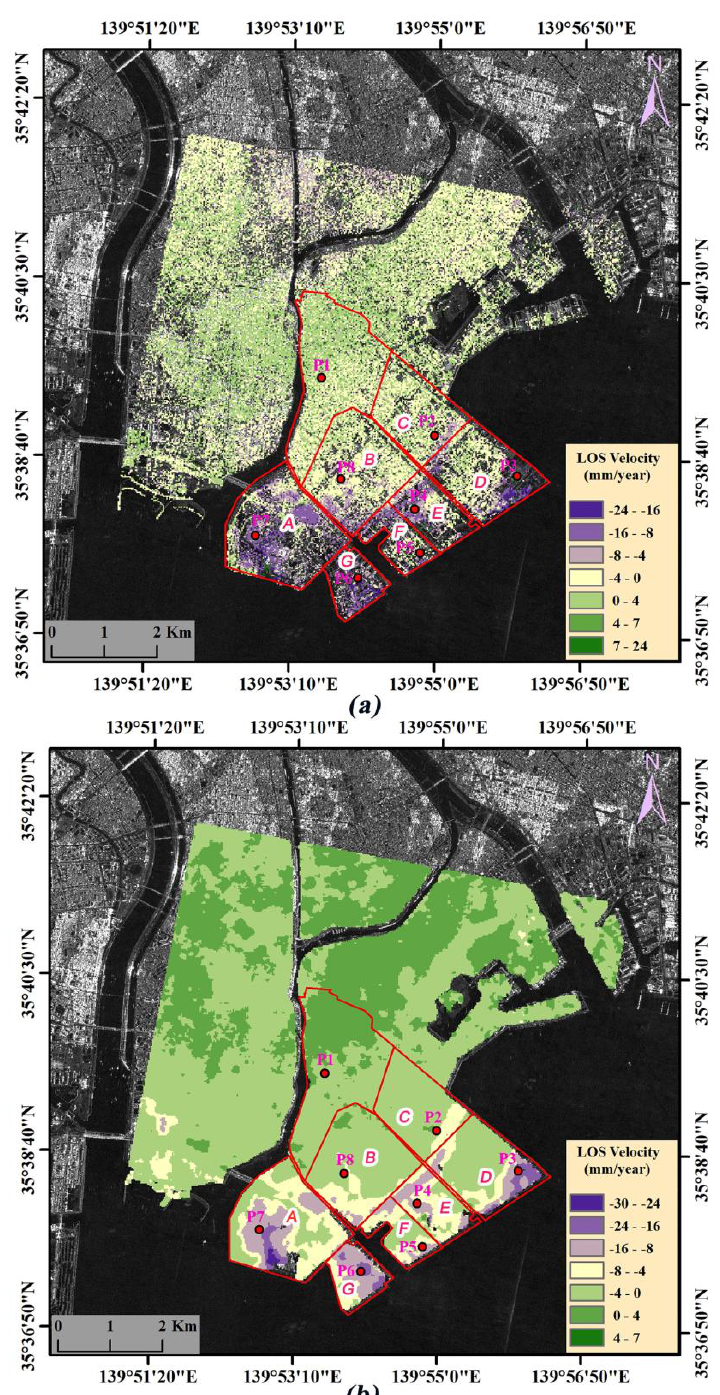
Figure 6. Mean LOS displacement velocity in Urayasu City from 2006 to 2010 for the PALSAR data: ( a ) estimated mean displacement velocity using the PSI method; ( b ) estimated mean displacement velocity using the SBAS method. The background image is a PALSAR-2 intensity image acquired on 04 December 2014. The red points P1 to P8 are the selected points to show the time-series LOS displacements estimated by the PSI and SBAS measurements in ( a ) and ( b ), respectively. A-G represent the reclaimed areas and districts which described in table 1.